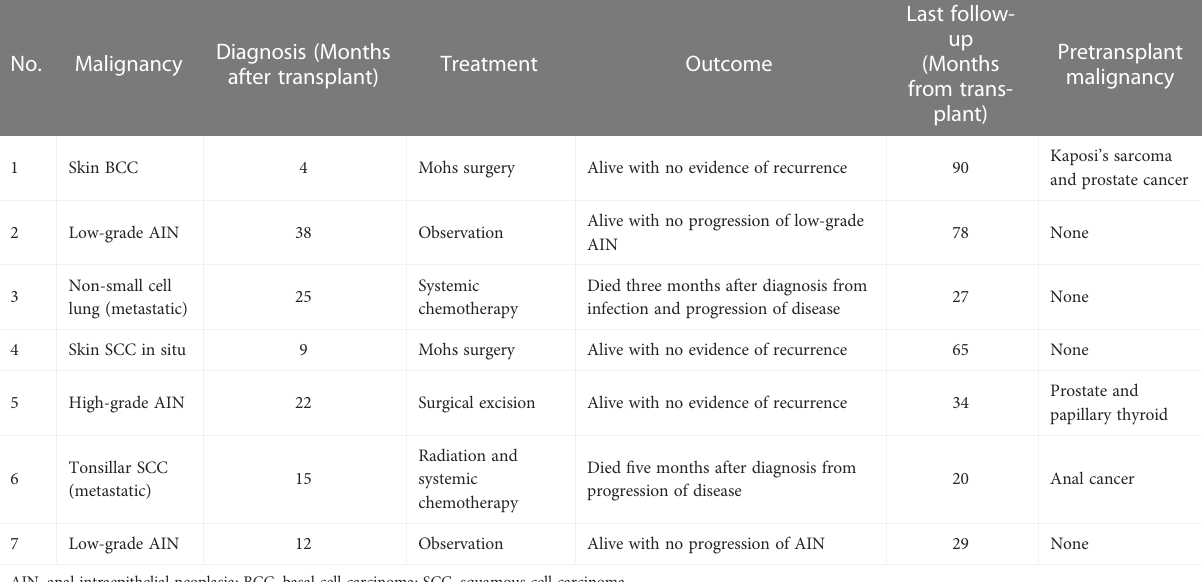
TABLE 2 Outcomes of HIV-infected individuals with kidney transplantation who developed malignancies within fi ve years of transplantation.